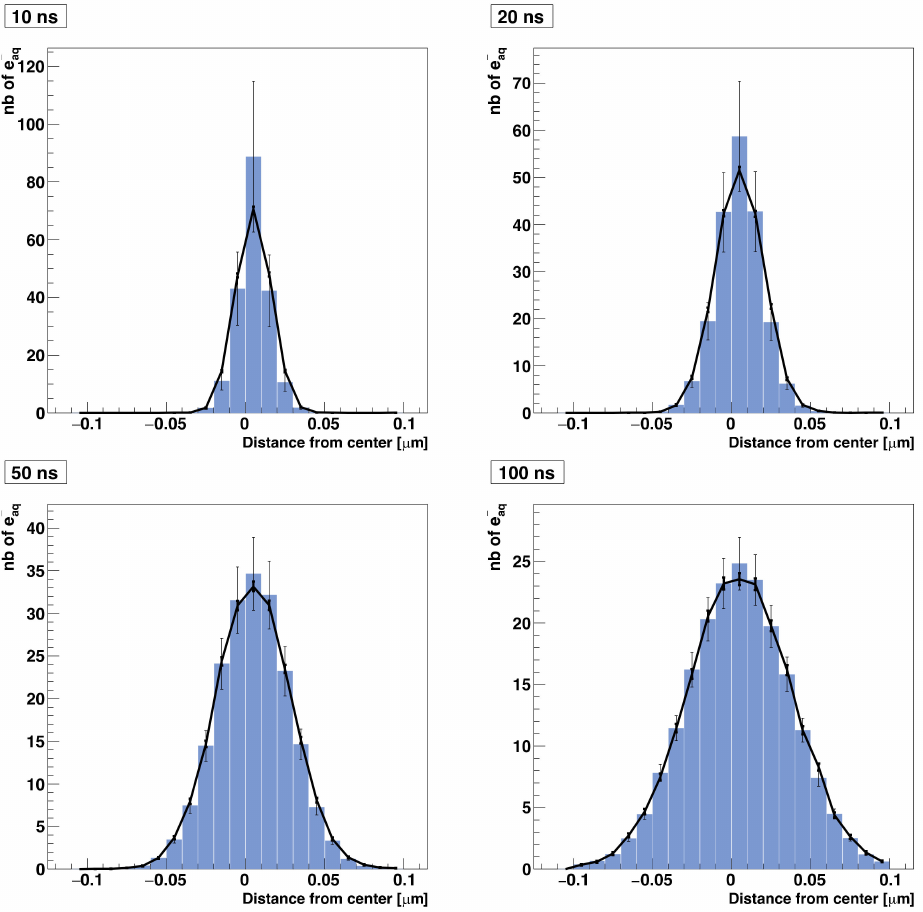
Figure 1. Comparison of spatial (radial) distributions of solvated electrons diffusing in water as computed with the RDME method (blue histogram with unbold error bars) and the SBS method implemented in Geant4-DNA (solid line with bold error bars). The distributions are computed at 10 ns, 20 ns, 50 ns, and 100